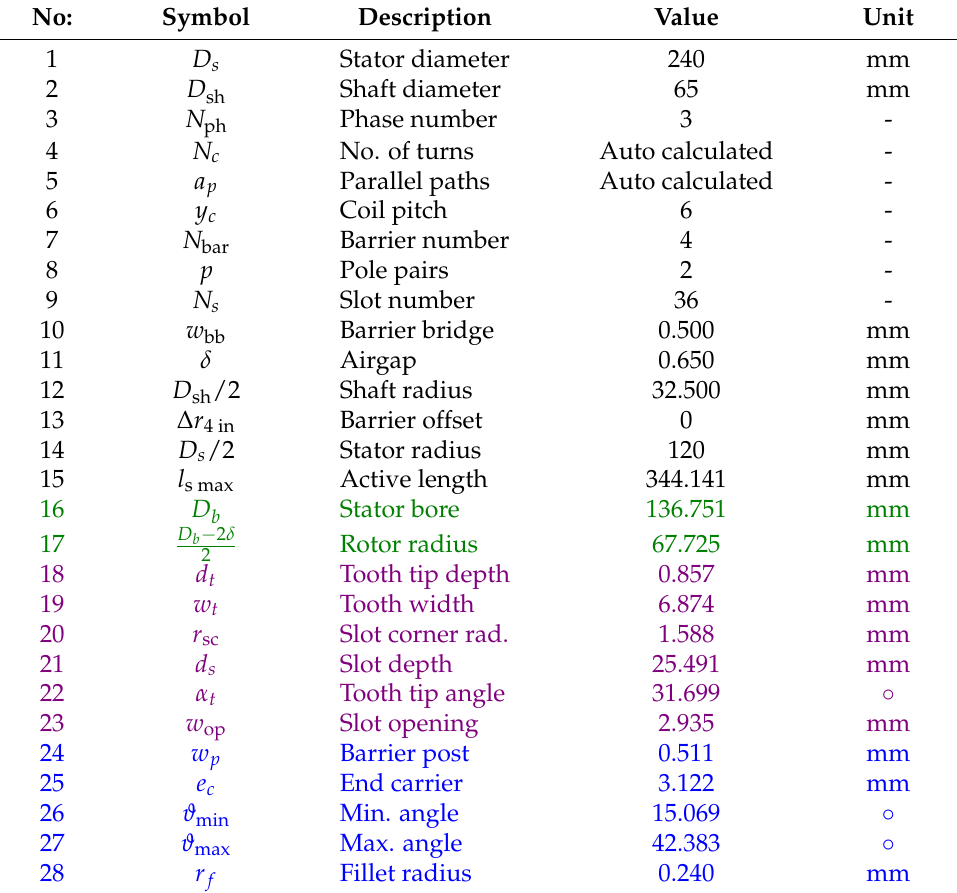
Table 2. Constant parameters.